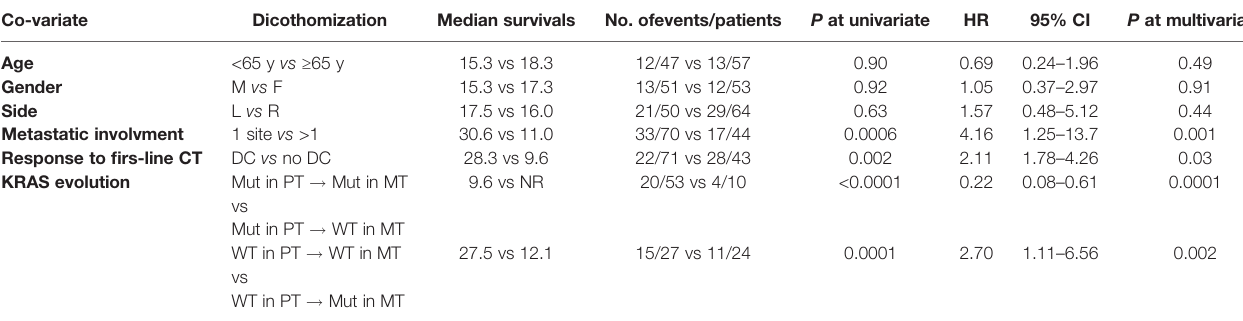
TABLE 5 | Multivariate analysis of RAS mutations ’ evolution prognostic power. Co-variate